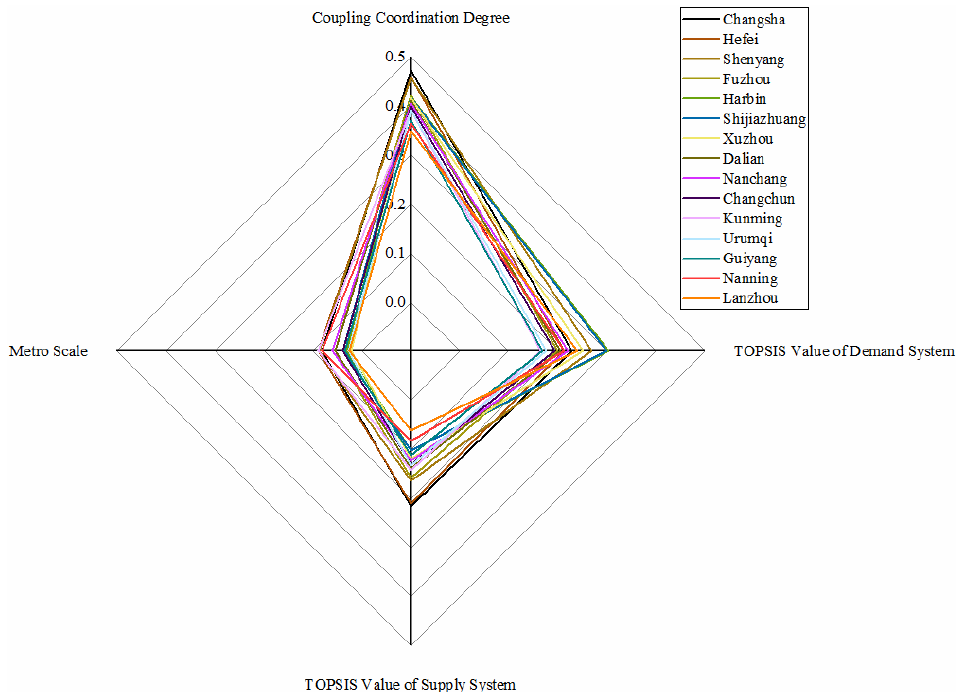
Figure 8. Metros in slightly unbalanced with lagging supply conditions.